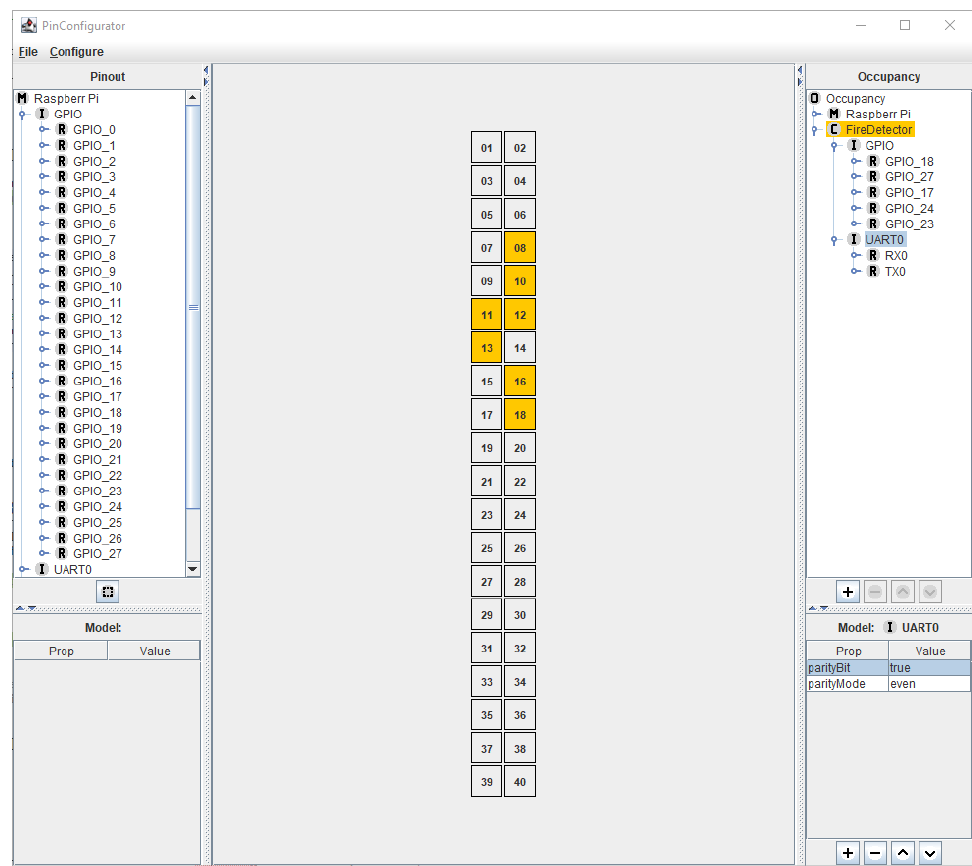
Figure 6. Screenshot of the PinConfig tool with the configuration for the fire detection application example. Note that there exist different pin numbering systems for the Raspberry Pi. The middle compartment uses the physical layout for pin numbering, while the left and right compartments use the BCM (Broadcom)